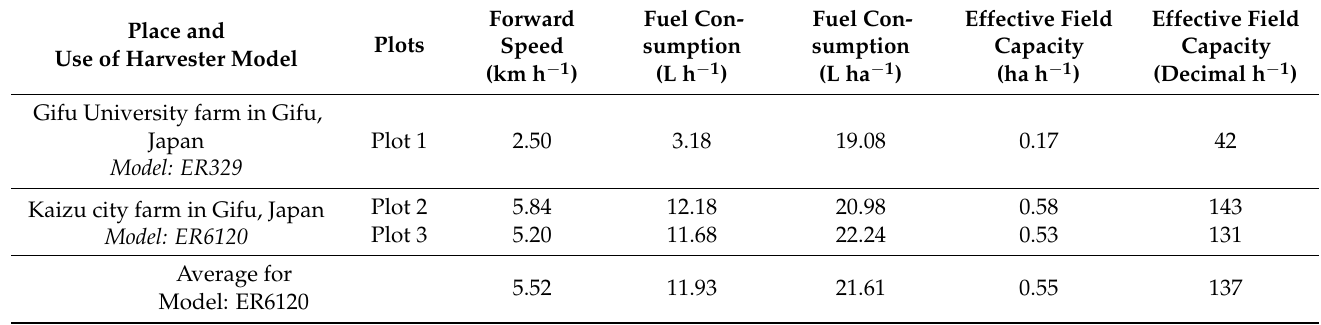
Table 4. Technical performance of the combine harvesters.